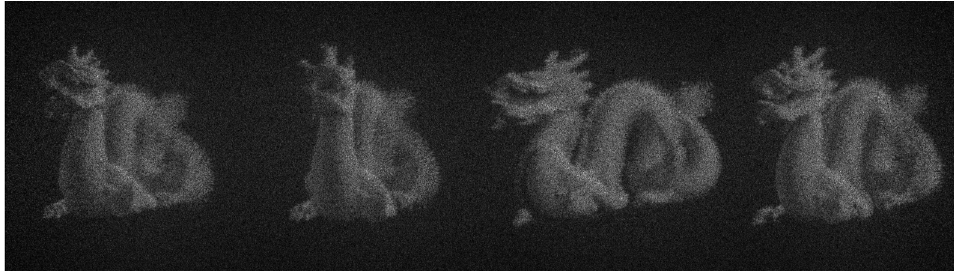
Figure 4. The schematic diagram of the synthetic hologram generation process. ( a ) the separation process of sub-images for view 1 ( b ) the generation process of hologram for view 1 ( c ) the Corre- spondence between holograms and viewpoints ( d ) the generation process for the synthetic holo- gram